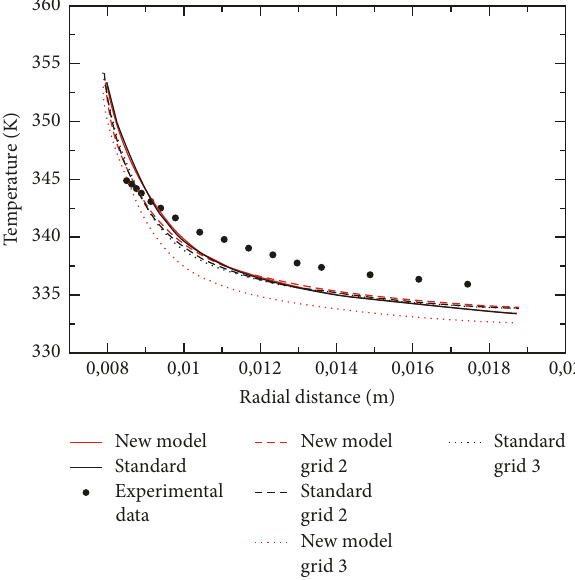
Table 8: Experimental conditions retained for the ASU experiment.